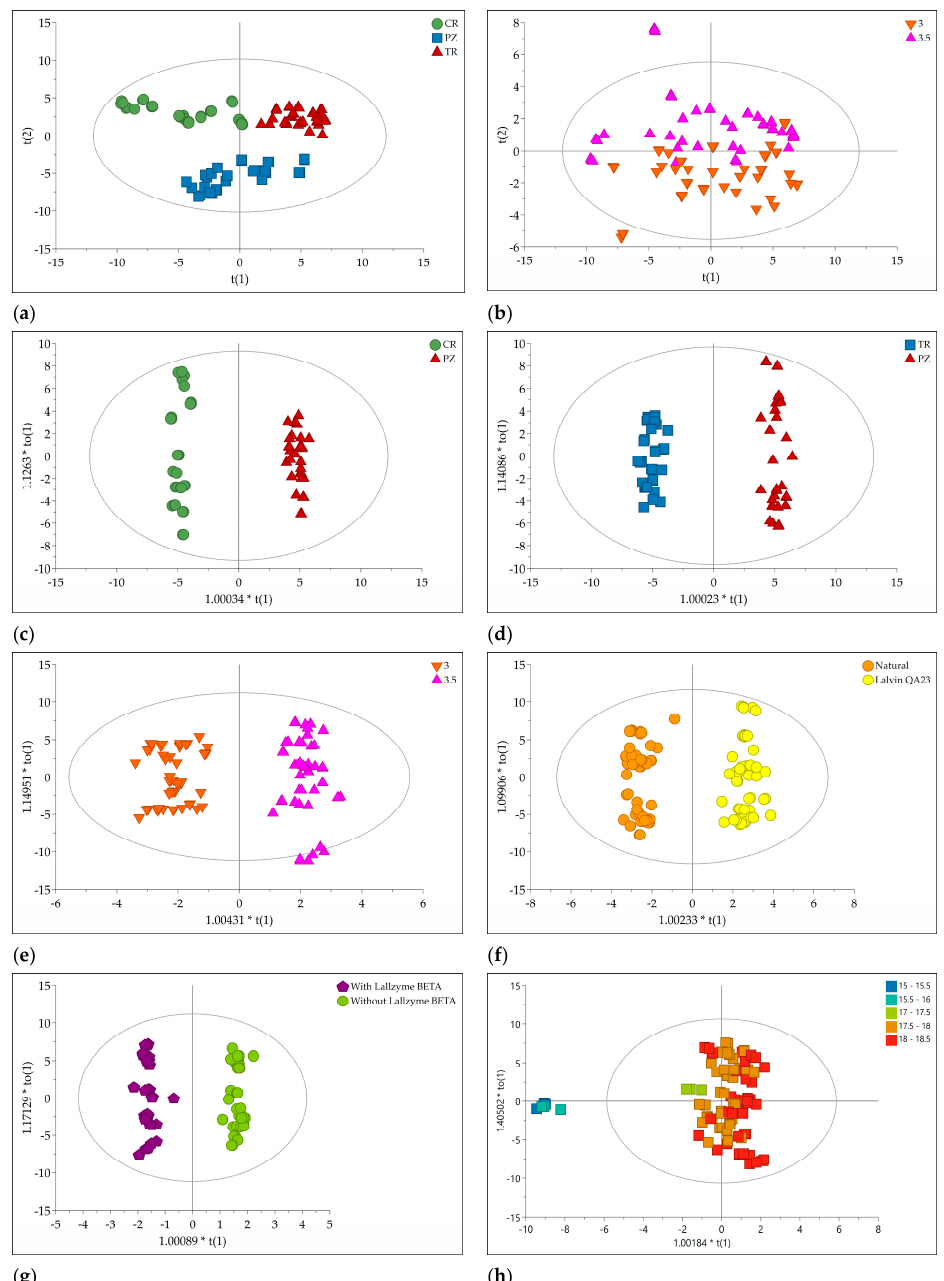
Figure 1. ( a ) PCA score plot (PC1 versus PC2) of all studied samples. The scores are colored according to the cultivars: CR—Crvena ranka, PZ—Požega č a, TR—Trnova č a; ( b ) PCA score plot (PC1 versus PC5) of all studied samples The scores are colored according to the pH of plum mash; ( c ) OPLS-DA score plot comprising cultivars CR versus PZ; ( d ) OPLS-DA score plot comprising cultivars TR versus PZ; ( e ) OPLS-DA score plot comprising different pH of plum mash, pH 3.0 versus pH 3.5; ( f ) OPLS-DA score plot comprising different yeast, natural versus Lalvin QA23™; ( g ) OPLS-DA score plot comprising enzyme addition, no addition versus Lallzyme BETA™; ( h ) OPLS score plot comprising correlation of brandy composition with its sensory properties. The scores are colored according to the grades of sensory